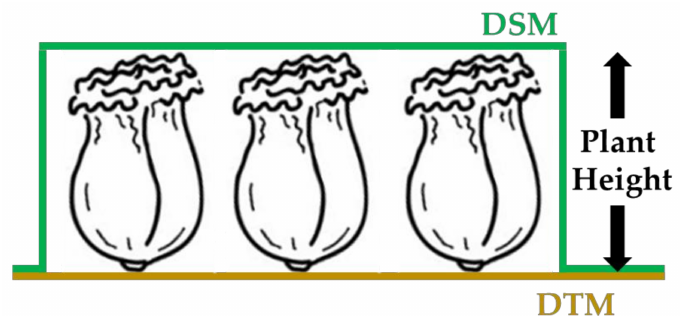
Figure 6. Schematic of calculating plant height based on the subtraction of digital terrain model (DTM) from digital surface model